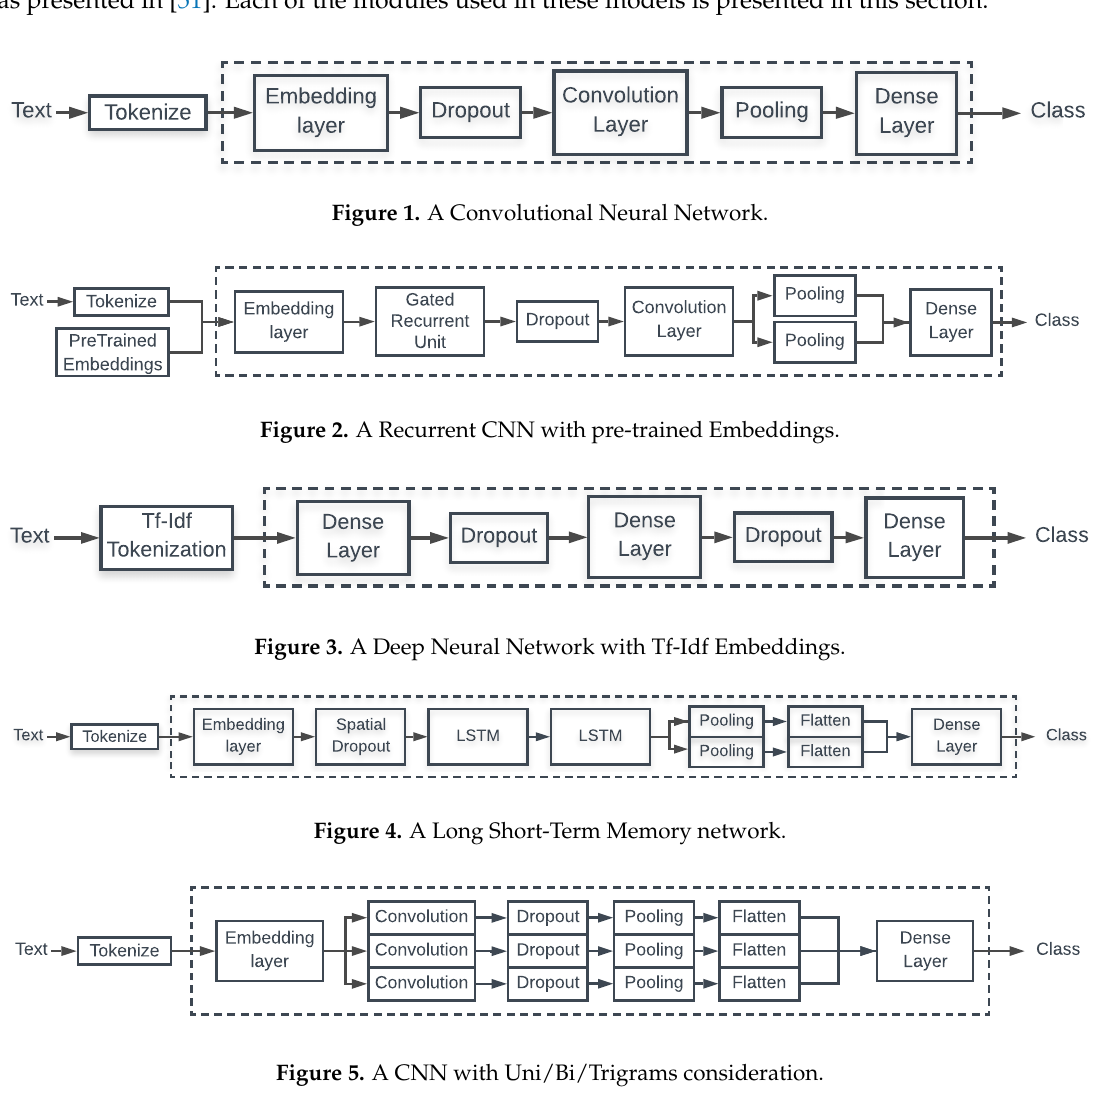
Figure 5. A CNN with Uni/Bi/Trigrams